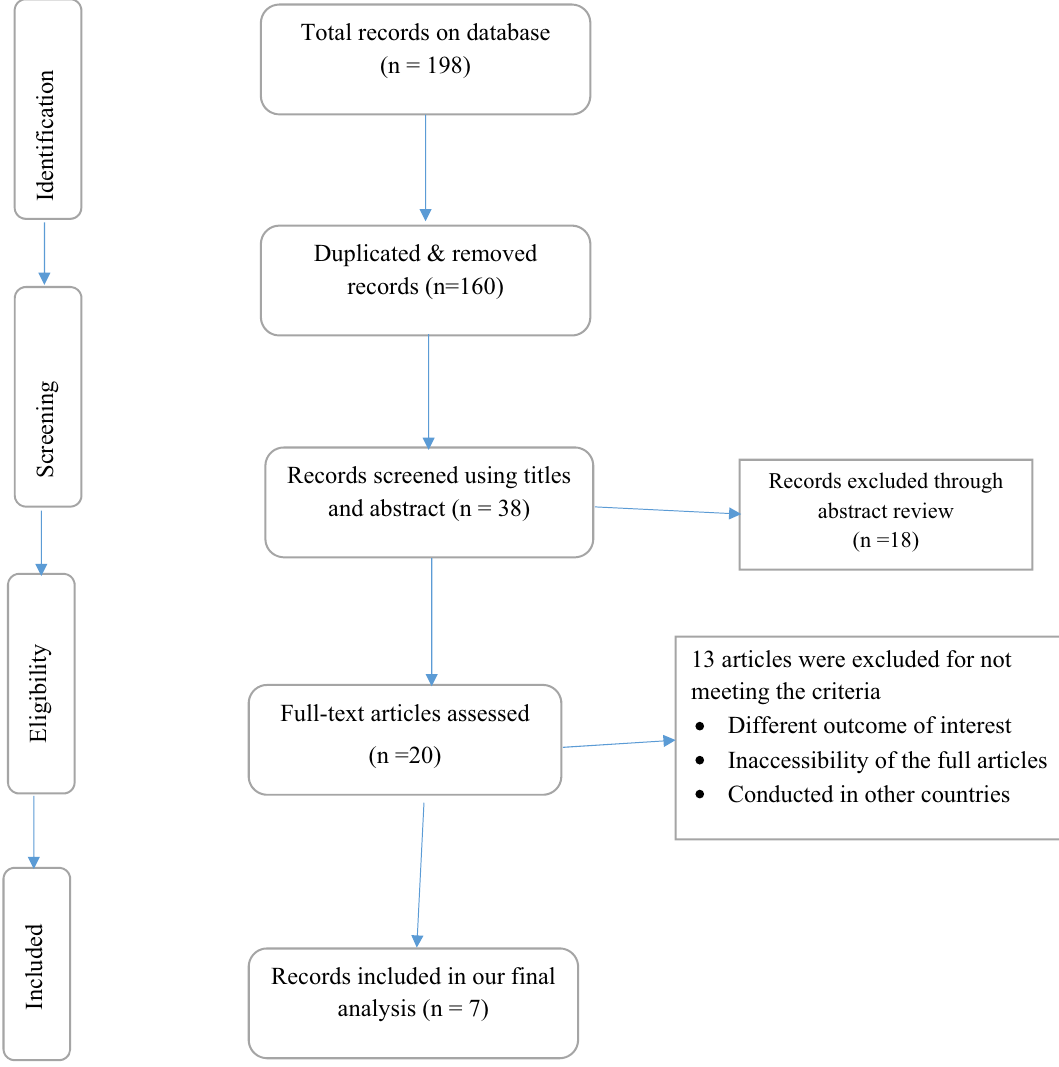
Figure 1. Flow chart showing records considered for systematic and meta-analysis of family planning usage and its association with knowledge of preconception care among women in